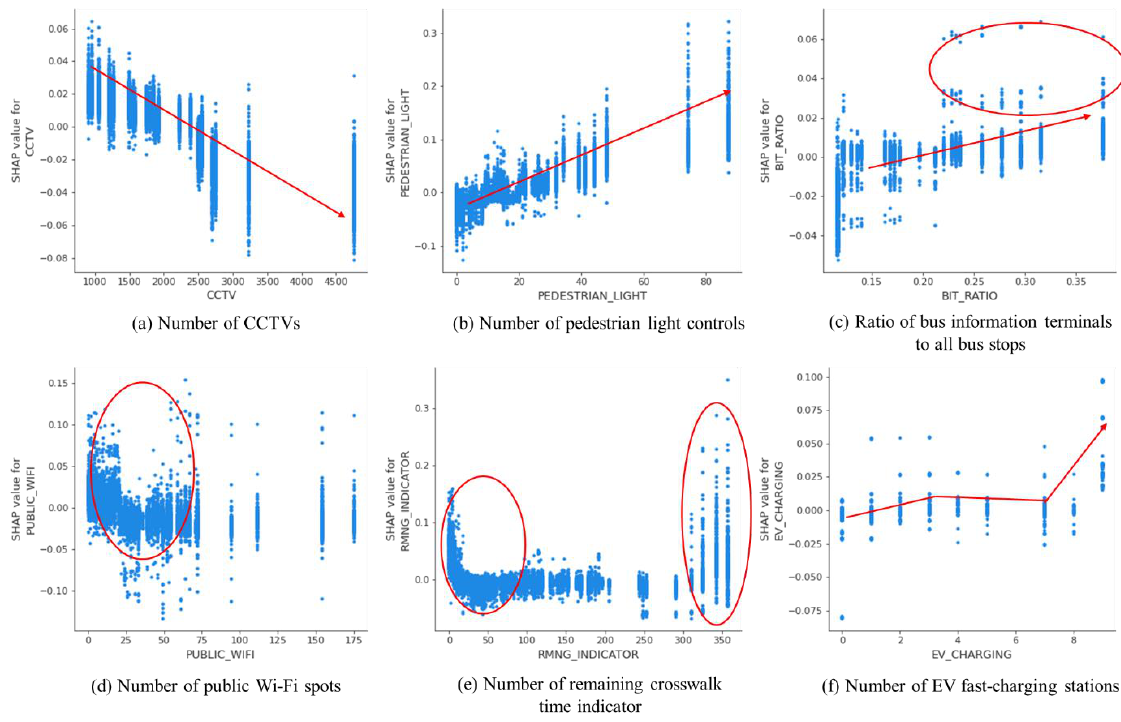
Figure 14. Dependence plots for features with clear patterns related to smart transportation systems.